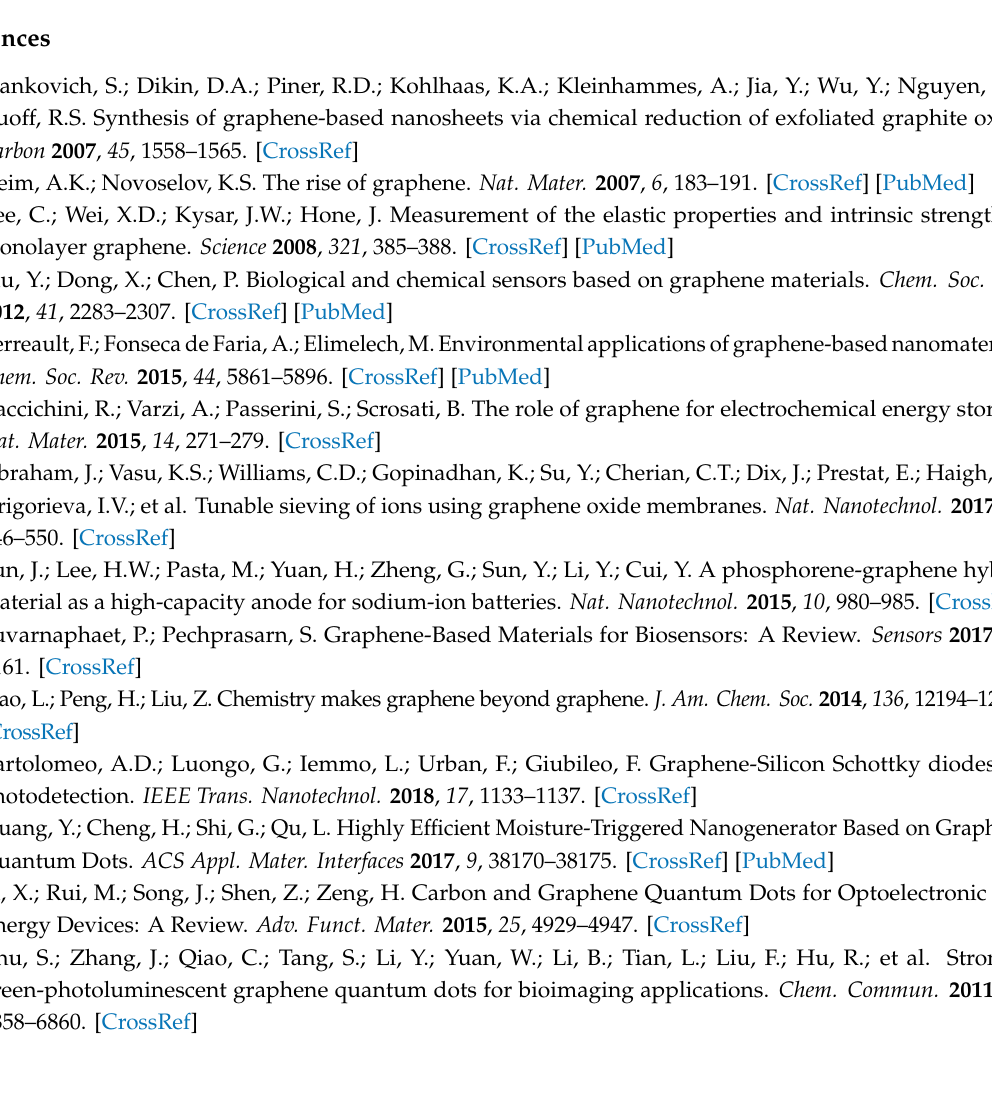
Figure S1: ( a ) XRD patterns and ( b ) Raman spectra of AG and FG. Figure S2: XPS patterns of GO-QDs ( a ) and GQDs ( b ). Figure S3: ( a ) TEM image of GQDs-NH 3 · H 2 O.and ( b ) FTIR spectra of GQDs-NH 3 · H 2 O and